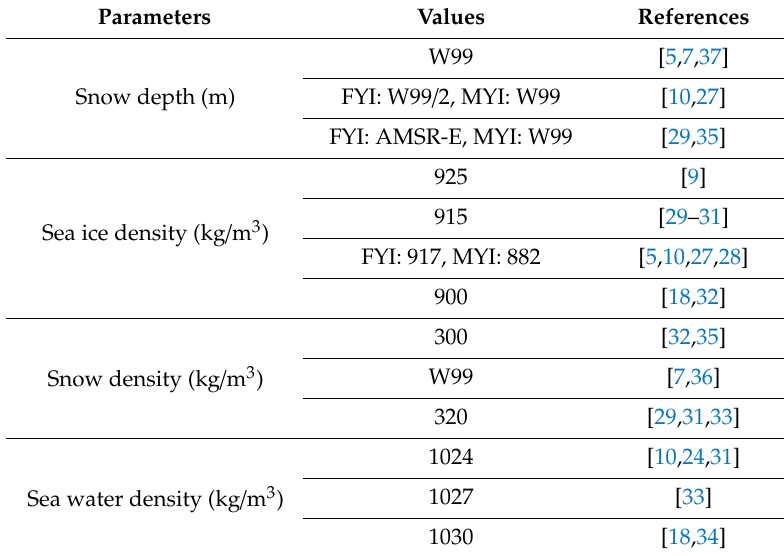
Table 1. Typical parameter values applied in previous